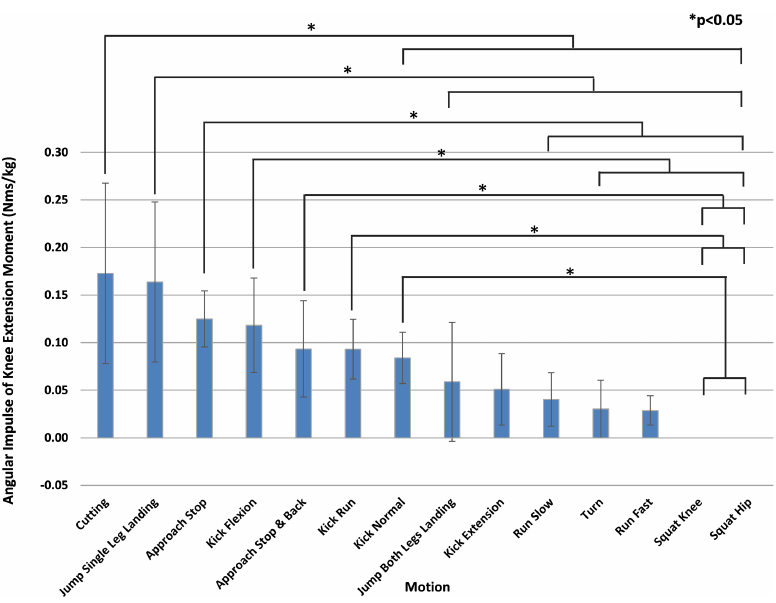
Fig 3. Motion comparison by averageangular impulse of the knee extension moment (1.5 Nm/kg or greater). Mean values are shown in descendingorder from left to right. "Cutting"was significantly greater than 8 types of motion, and "Jump SingleLeg Landing"was significantly greater than 7 types of motion. Multiplecomparisons were performed after ANOVA to show statistically significantdifferences between motions. * P <